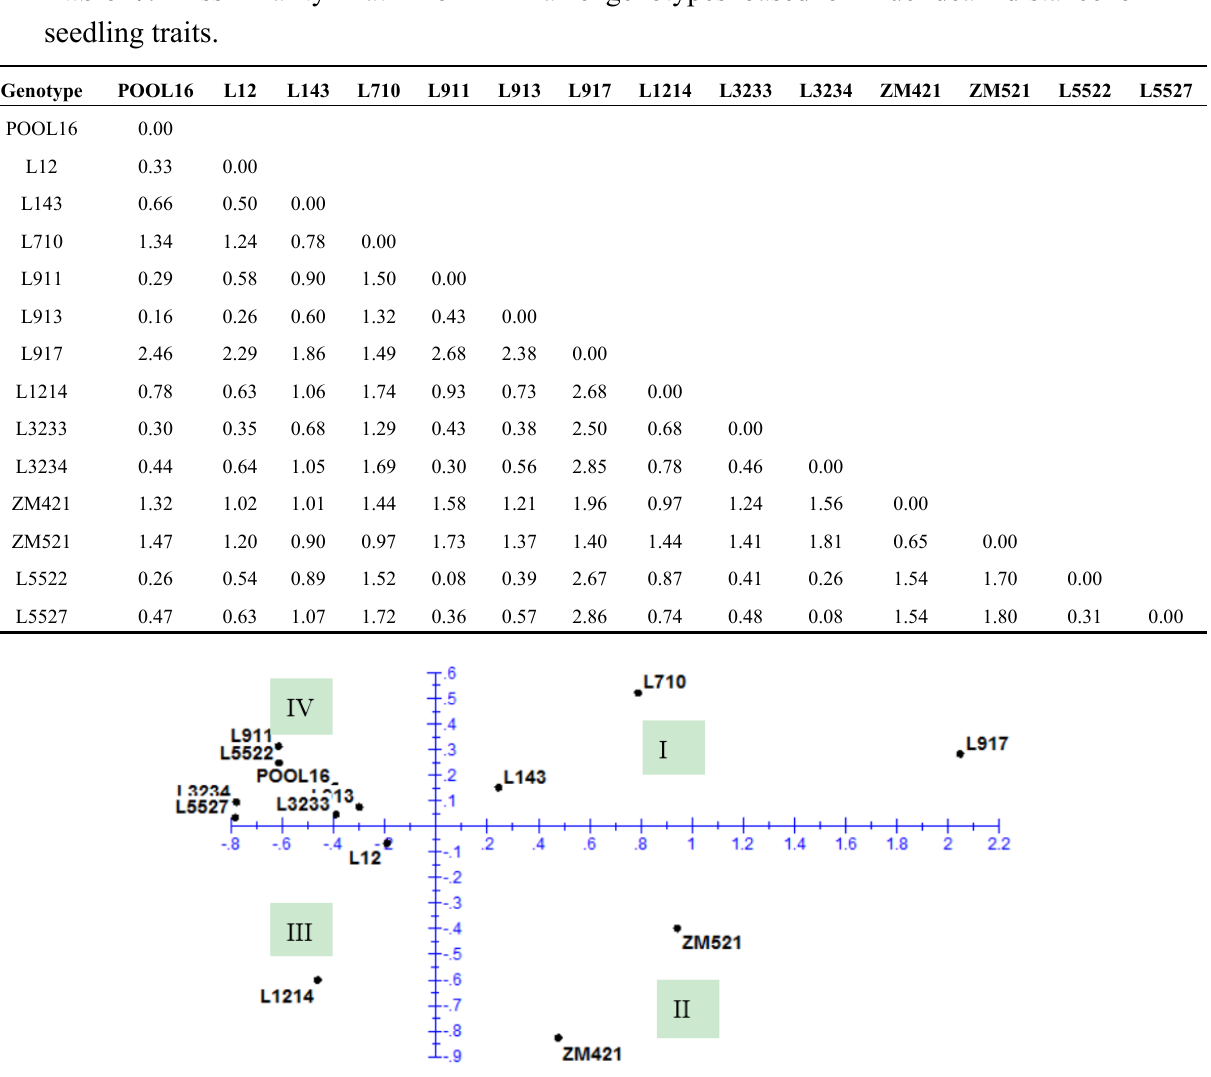
Figure 1. A plot of principal coordinate analysis of 14 genotypes based on the Euclidean distance of eight seedling